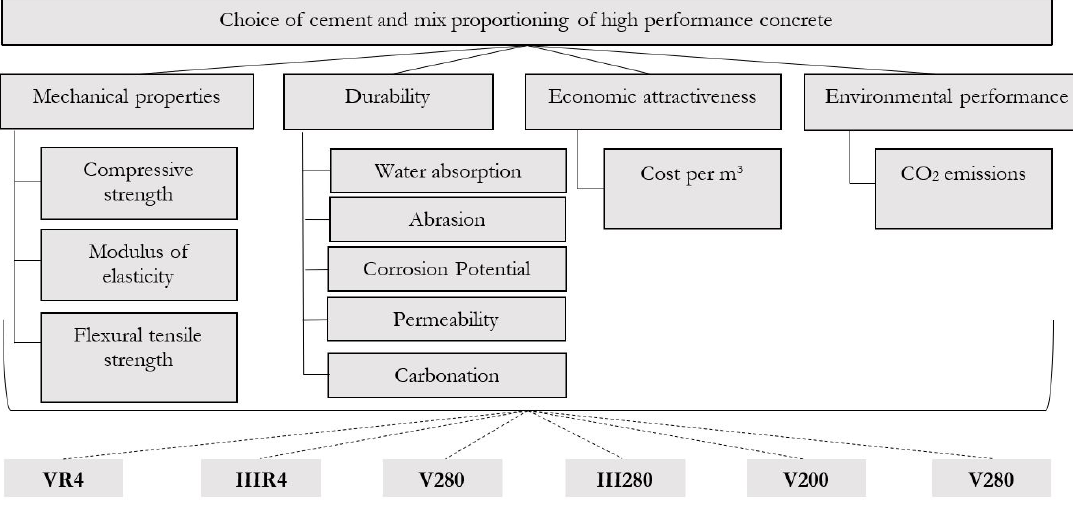
Figure 2. Criteria and sub-criteria